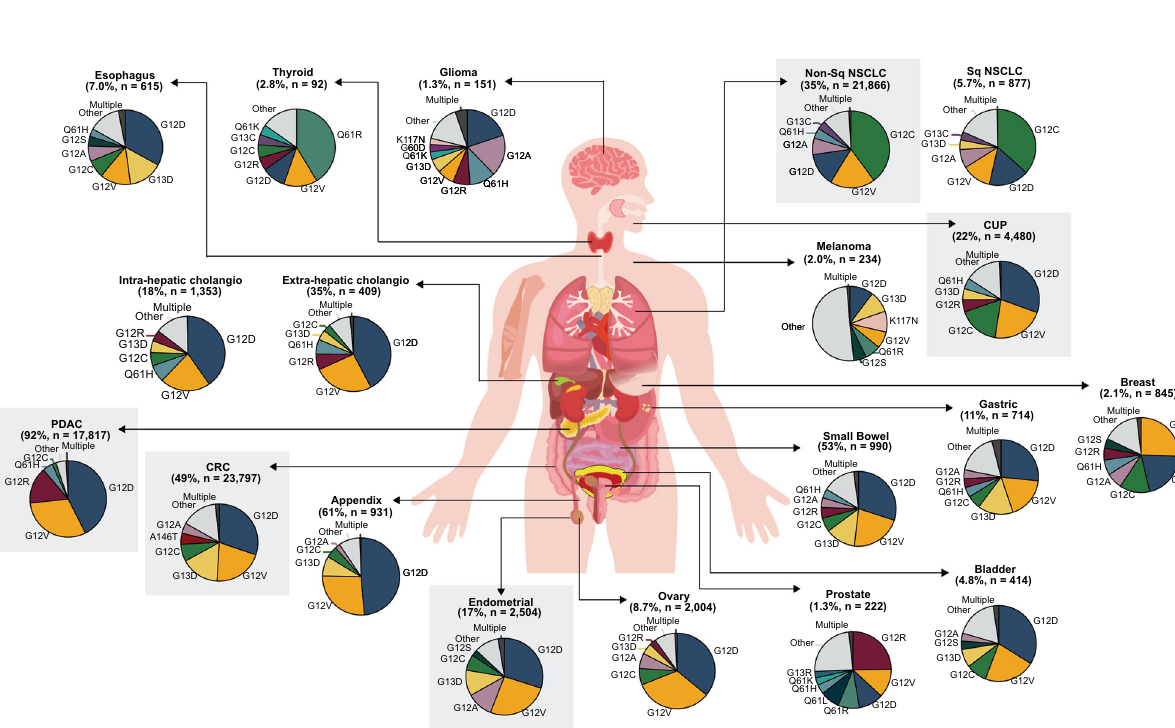
Fig. 2 Prevalence of KRAS alteration subtypes by tumor type. a Bar graph showing the prevalence of the most common types of KRAS alterations across indications. Disease subtypes are ordered based on the cumulative prevalence across the six highlighted KRAS alteration subtypes. Only tumor types with at least 250 total samples and a total KRAS alteration prevalence of at least 5% are shown. b Anatomic visualization of the prevalence of KRAS mutant isoforms. Percentage of total cases with KRAS mutations is shown for each tumor type and the corresponding ‘ n ’ for number of KRAS mutated cases. The four major tumor types assessed in this study as well as carcinoma of unknown primary (CUP) are highlighted in gray and represent the largest KRAS mutant populations. Major tumor types with relatively low prevalence of KRAS alterations such as breast, prostate, glioma, and melanoma are also shown. The body part background was custom designed by www.slideteam.net